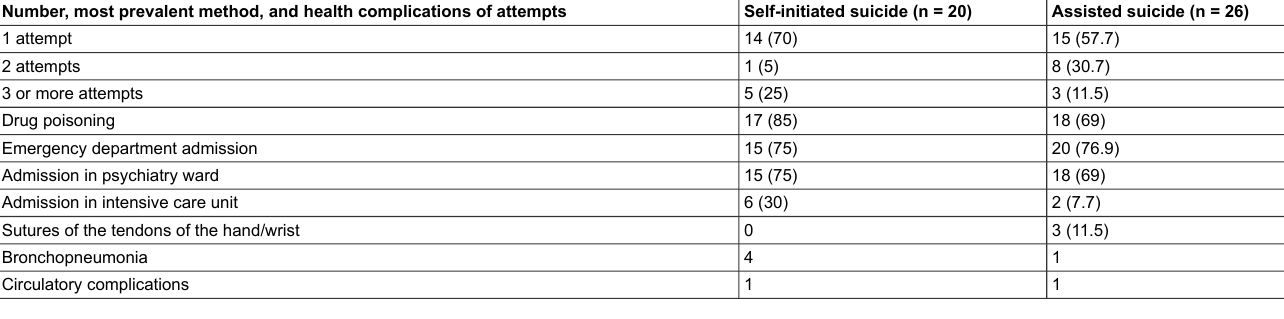
Table 3: Characteristics of attempts, in assisted and unassisted suicide decedents, Geneva, Switzerland, 2010–2019. Number, most prevalent method, and health complications of